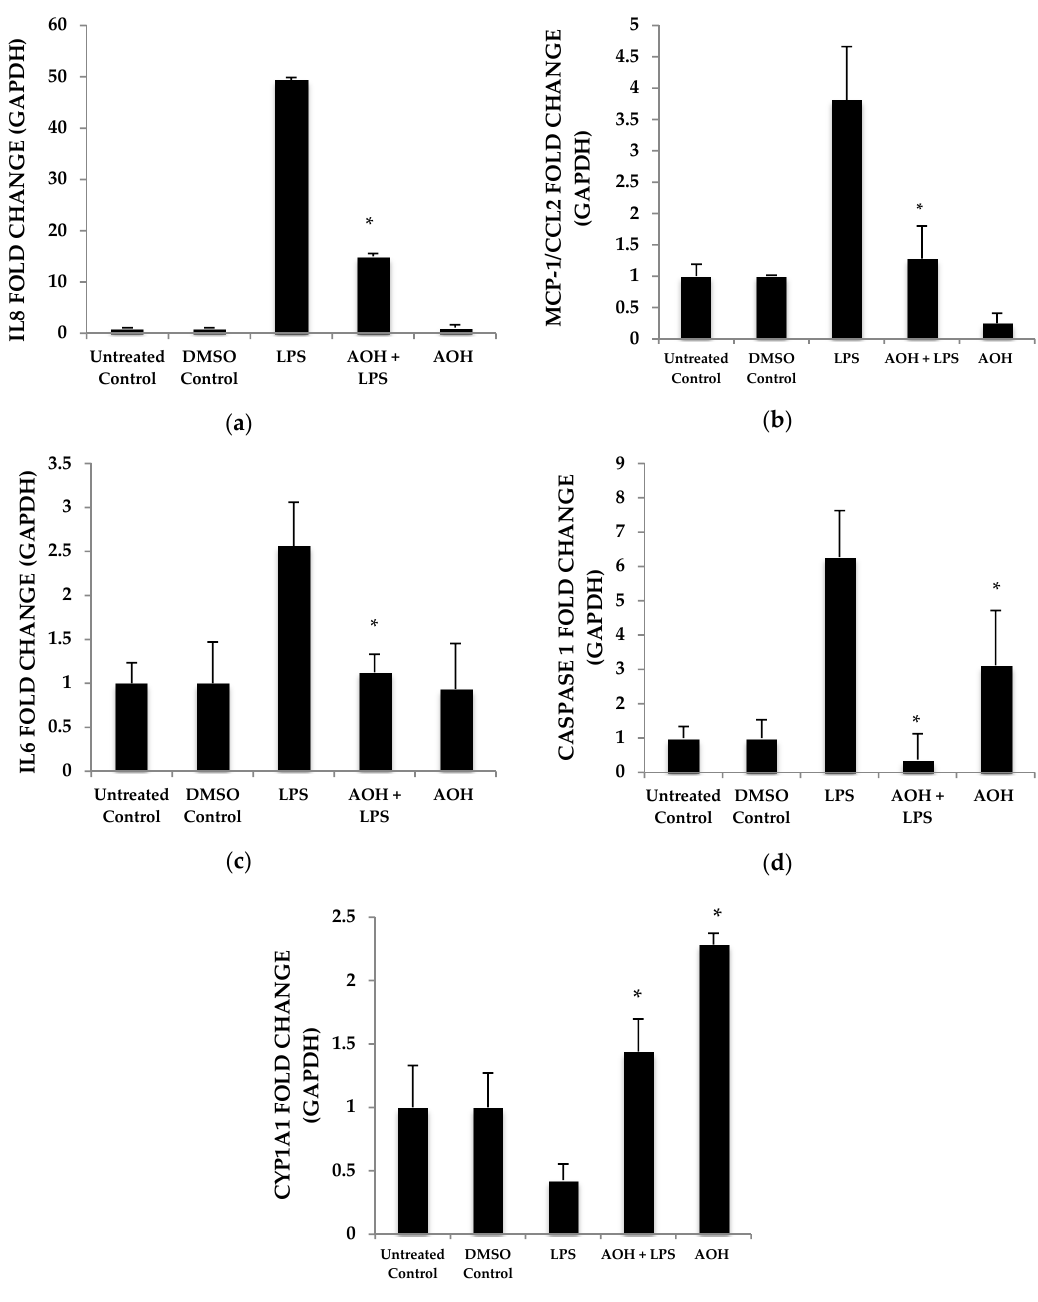
Figure 3. Airway epithelium treated with alternariol (AOH) and alternariol monomethyl ether (AME) results in the downregulation of LPS-induced mRNAs. BEAS-2B cells seeded at a density of 5 × 10 5 cells/well were treated with 10 μ M AOH and 10 μ g LPS for 24 h. The resulting RNA was harvested and measured with quantitative real-time reverse transcription-polymerase chain reaction (qRT-PCR). Each graph here demonstrates the upregulation and downregulation (fold change) of gene expression by normalization with the control GAPDH. ( a ) IL8, ( b ) CCL2, ( c ) IL6, ( d ) Caspase 1, and ( e ) CYP1A1 fold change. An * indicates p < 0.05 according to Student’s t -test when comparing AOH to dimethyl sulfoxide (DMSO) control and AOH + LPS to LPS corresponding control.